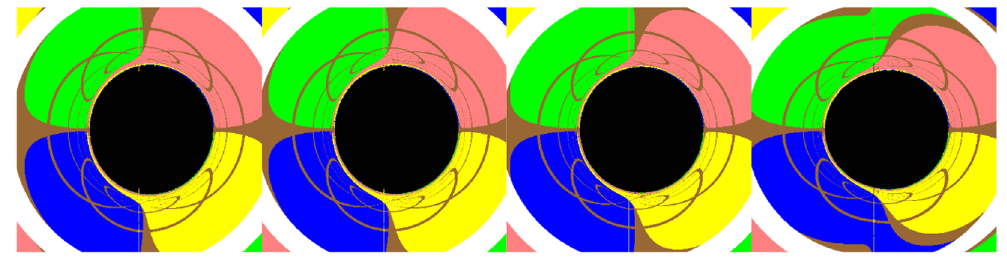
Figure 2 . The change of black hole shadow with the coupling constant α for the metric (2.21). Here we set the black hole M = 1 and rotation parameter a = 0 . 5, and the observer locates in the position with r obs = 50 M and θ obs = π/ 2. The figures from left to right correspond to α = 0 . 2, 0, and 0 . 2, −